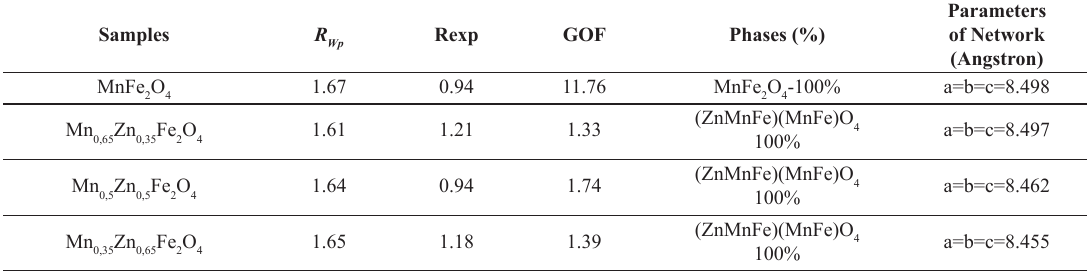
xZn Fe O samples (x = 0, 0.35, 0.5 and 0.65). 1- x 2 4